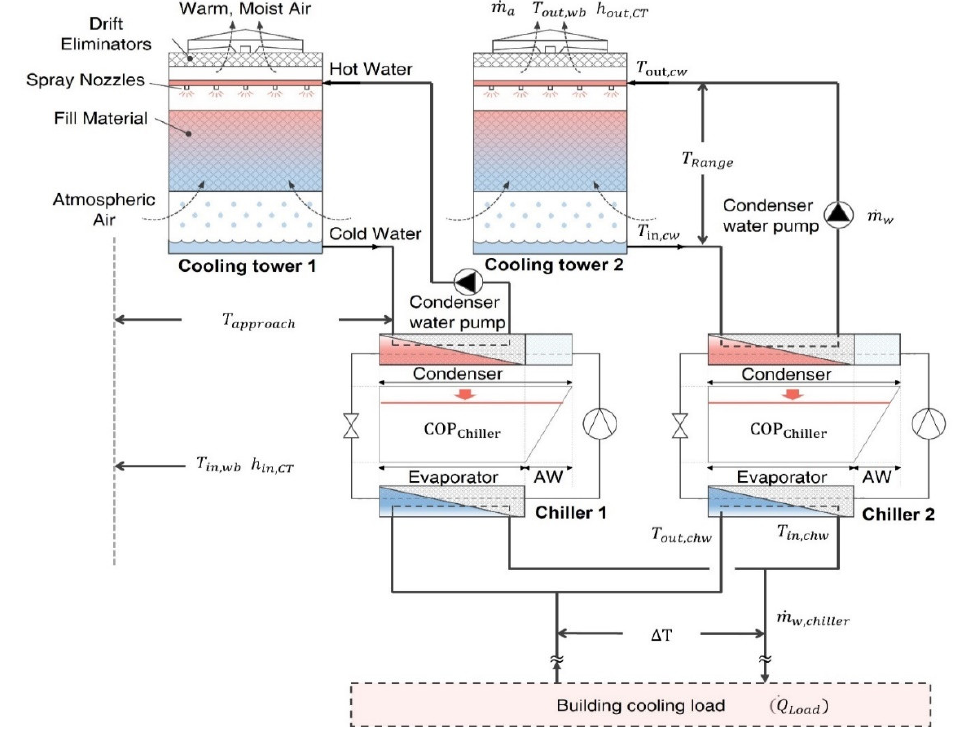
Figure 5. Conventional cooling tower (Case A, B, C, D).